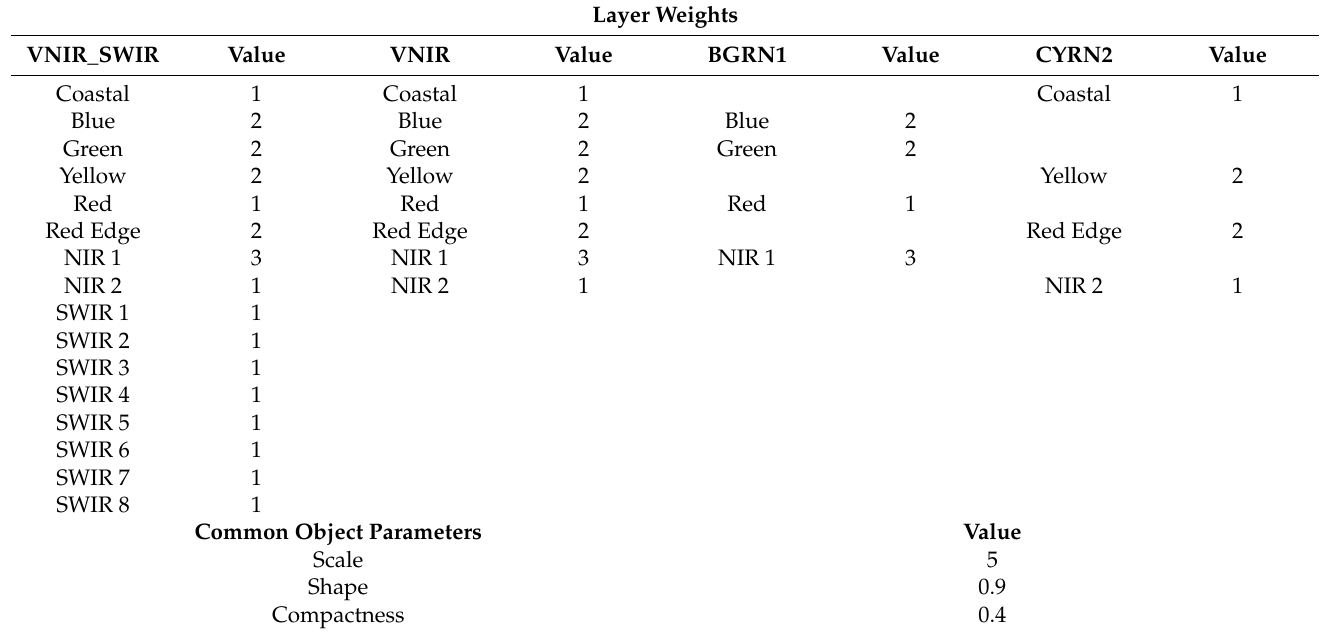
Table 4. Parameters used to implement multiresolution